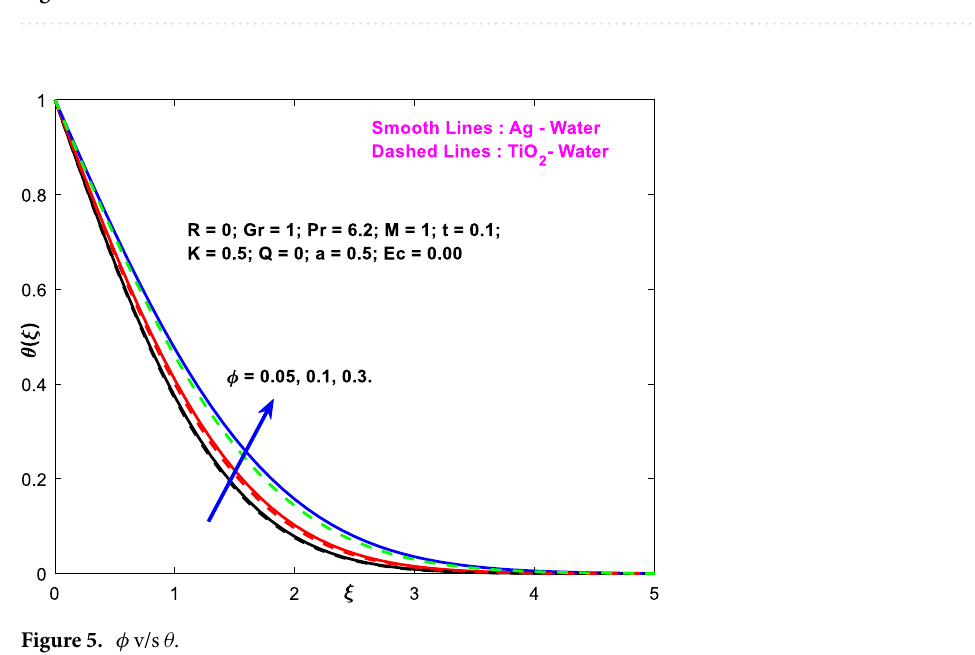
Figure 4. R v/s u .